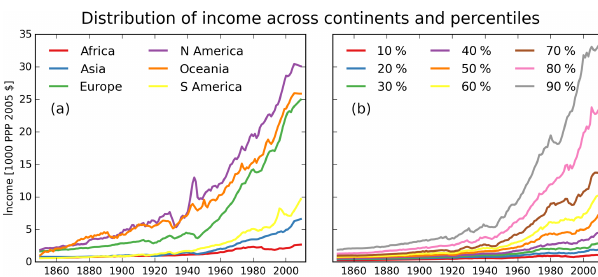
Figure 5. Distribution of population-weighted income over time across continents (a) and percentiles (b) that can be analyzed for, e.g., income inequality or other distributional effects. Percentiles rank the number of countries by average national